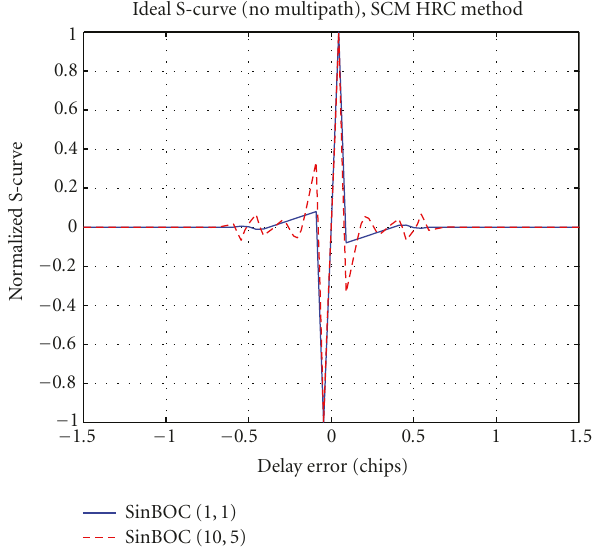
Figure 13: SCM HRC method: ideal S-curves (no multipath), for two BOCmodulation cases, with a = − 1 / 2 and Δ = 0 . 1 chips.